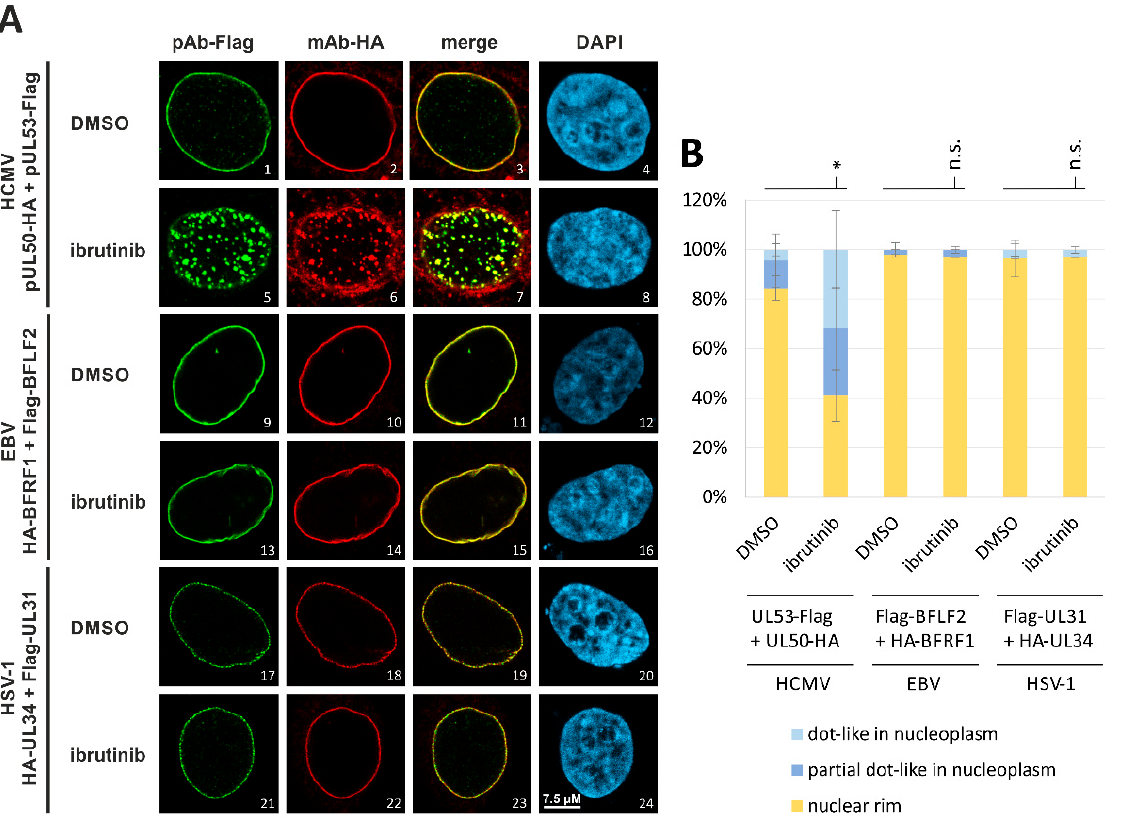
Figure 10. Inhibitory impact of hit compound ibrutinib on the localization of three different herpesviral core NECs in plasmid-cotransfected cells. ( A ) HeLa cells were cotransfected with each two of the indicated NEC expression plasmids (HSV-1 HA-UL34 + Flag-UL31, HCMV pUL50-HA + pUL53-Flag and EBV HA-BFRF1 + Flag-BFLF2). Ibrutinib was applied at a concentration of 4 µM immediately after transfection. At 3 d post-transfection (p.t.), cells were fi xed, used for IF staining with the indicated tag antibodies and analyzed for intranuclear localization by confocal imaging. DAPI counterstaining represented the nuclear morphologies of the respective cells. Additional single channel images in grayscale, allowing easier comparison of signal patterns, are presented in Figure S4. For raw data, see https://doi.org/10.5281/zenodo.7794233, accessed on 3 April 2023. ( B ) Quantitation of this IF analysis was achieved by counting 50 cells per biological triplicate. Three patterns of pUL53 localization were distinguished, i.e., normal nuclear rim (yellow), partial dot-like intranucleoplasmic aggregation (dark blue) and predom- inant dot-like aggregation (light blue). Mean values ± SDs are given. Statistical analysis was performed using ordinary one-way ANOVA and post hoc Tukey testing on combined dot-like pUL53 localization values of DMSO in relation to the analyzed ibrutinib concentration and MBV; * p ≤ 0.05; n.s., not